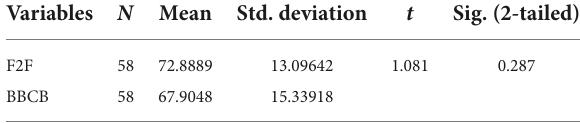
TABLE 7 Students’ achievements in Blackboard (BB) and face-to-face (FTF) classroom